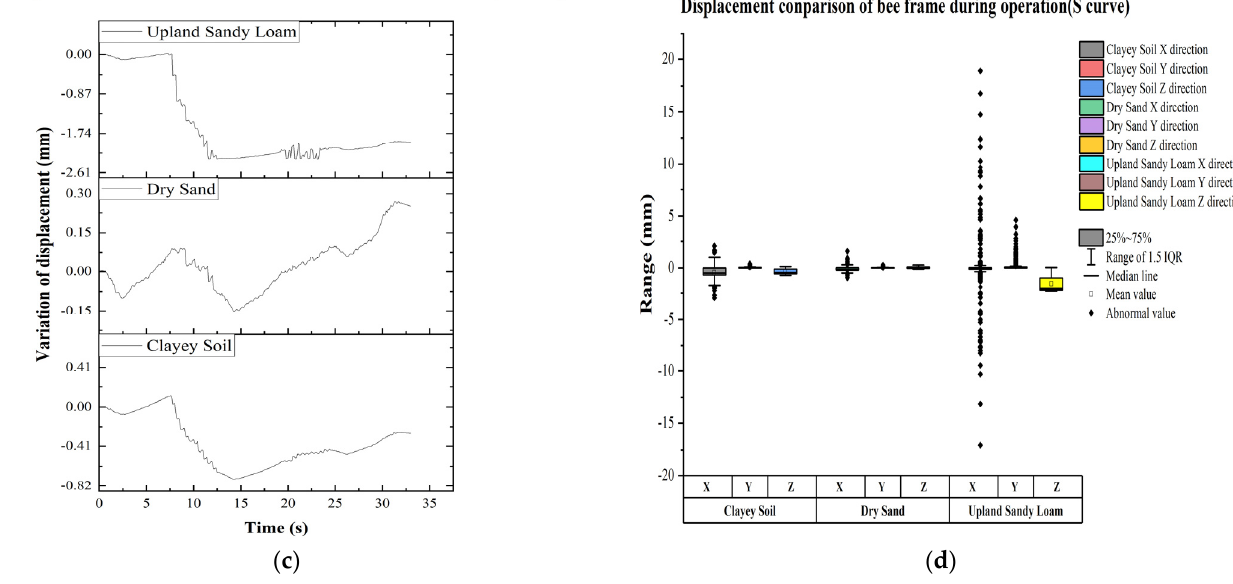
Figure 17. Variation of relative displacement in ( a ) the X-direction of the bee frame (s-turn), ( b ) Y- direction of the bee frame (s-turn), and ( c ) Z-direction of the bee frame (s-turn). ( d ) Range of the XYZ directions for the bee frame (s-turn).